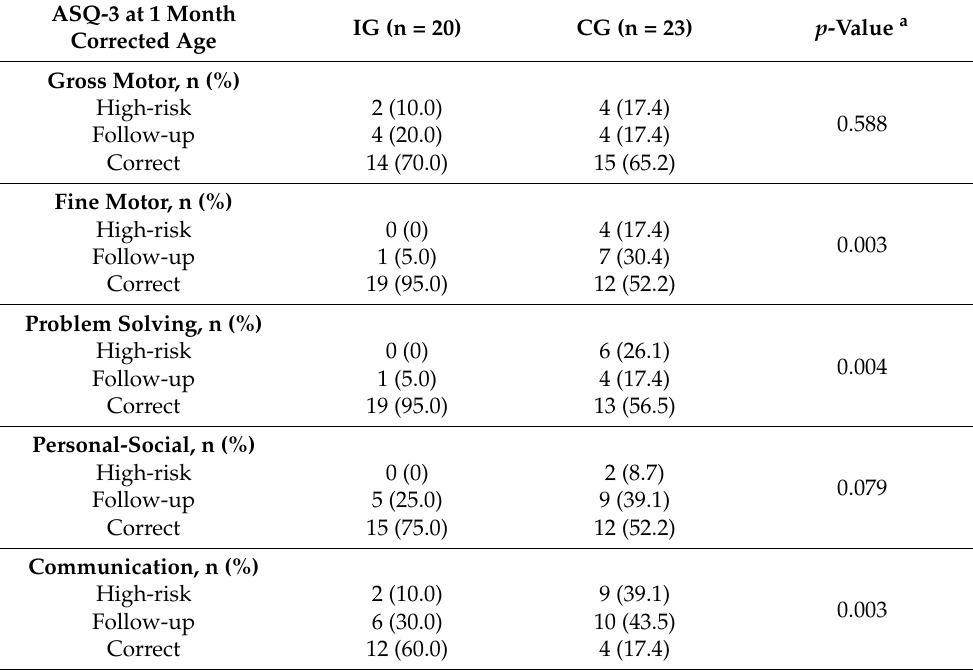
Table 4. Results of Ages and Stages Questionnaire—version 3 (ASQ-3) at 1 month corrected age.